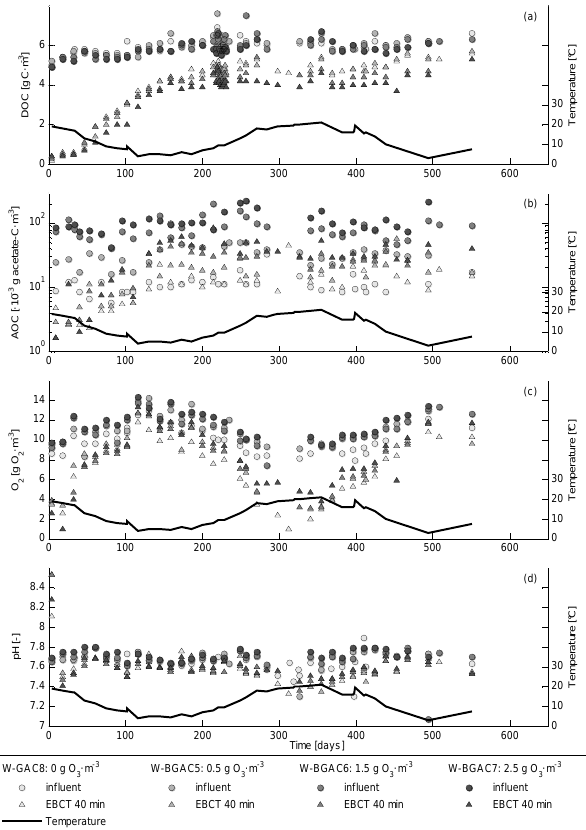
Figure 2. DOC (a) , AOC (b) , oxygen (c) and pH (d) in Weesperkarpsel pilot (B)GAC